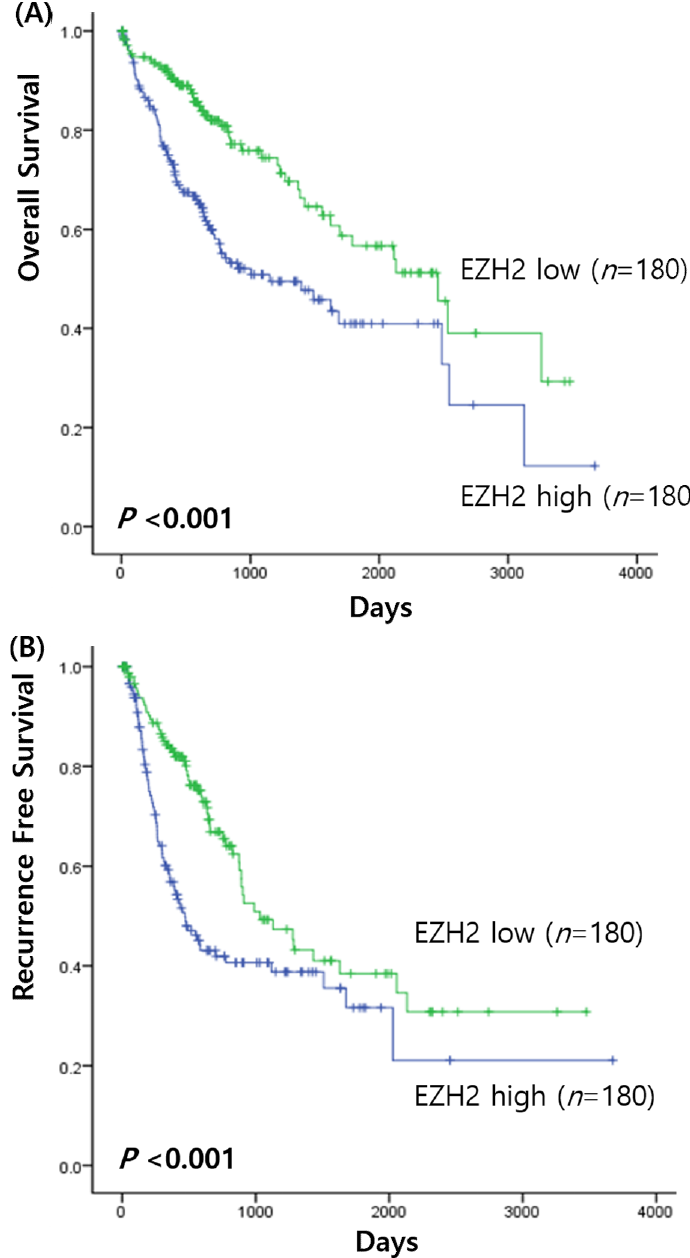
Figure 1. Survival analysis in HCC. ( A ) Overall survival of EZH2 expression; ( B ) recurrence free survival of EZH2 expression.